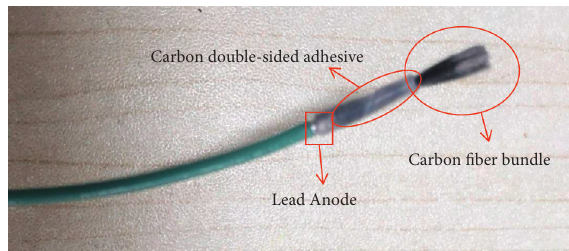
Figure 3: Carbon fiber bundle-modified TTCP lead.